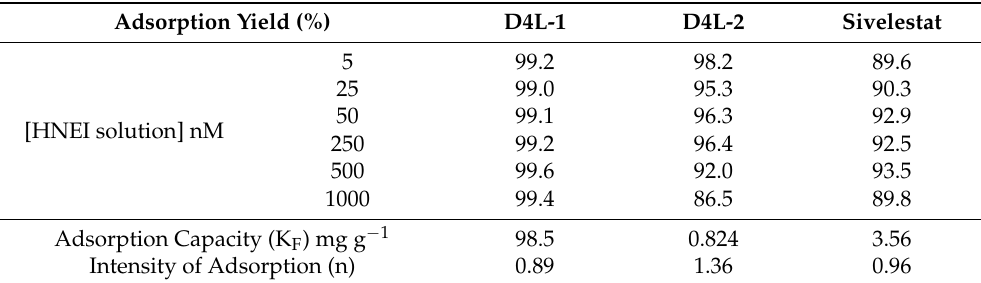
Table 2. Adsorption data for D4L-1, D4L-2, and Sivelestat-PSU doped